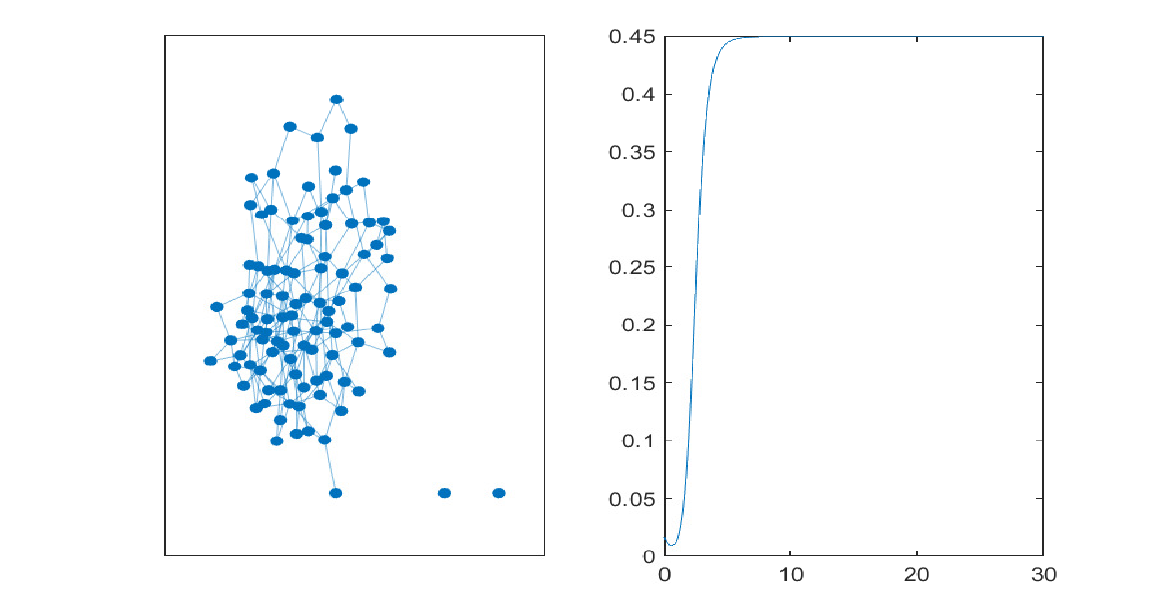
Figure 10. High level of connectivity: Erdös–Rényi graph with 100 nodes and a connection probability of p = 0.04 ( left ). Time evolution of the mean value of non-performing loans on the graph ( right